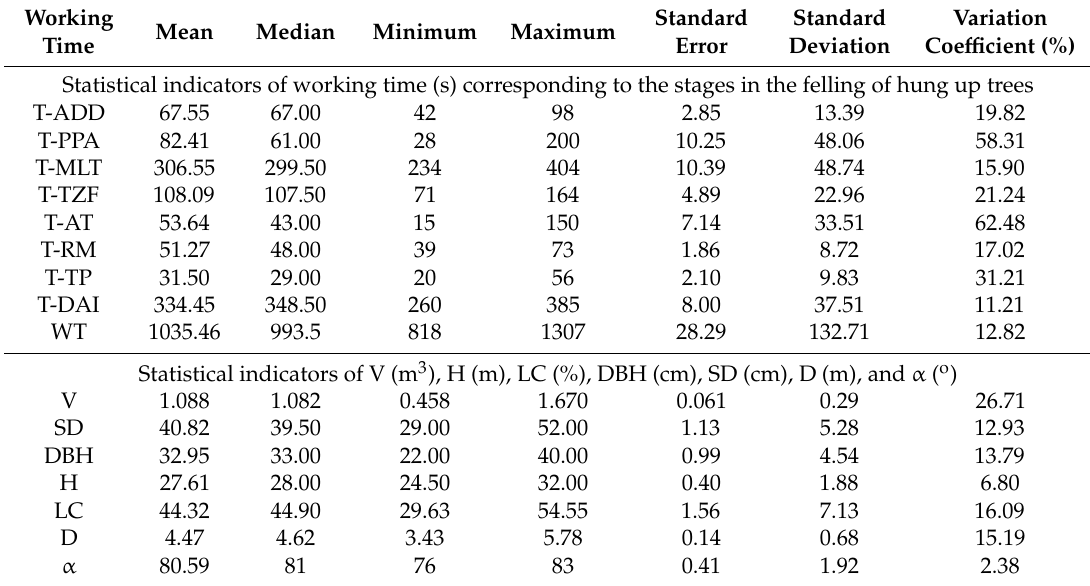
Standard Standard Variation Error Deviation Coe ffi cient (%)